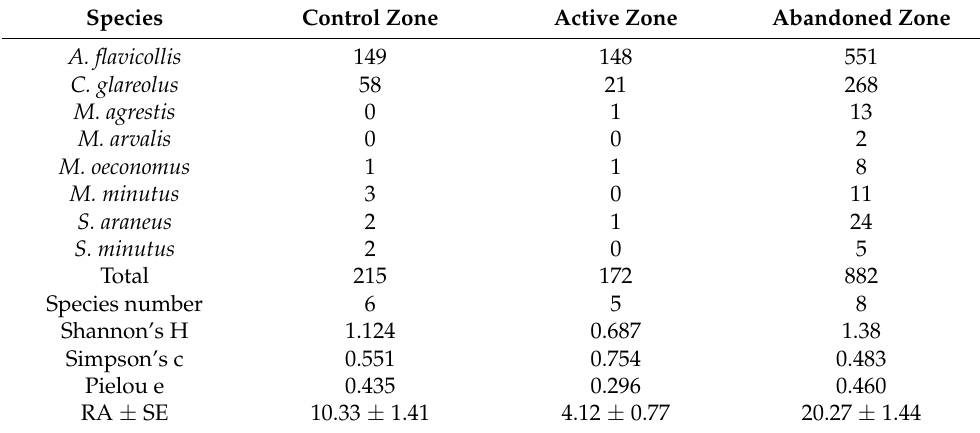
Table 1. Small mammal community structure, diversity, and relative abundance in Juodkrant˙e cormorant colony, 2011–2022. Species Control Zone